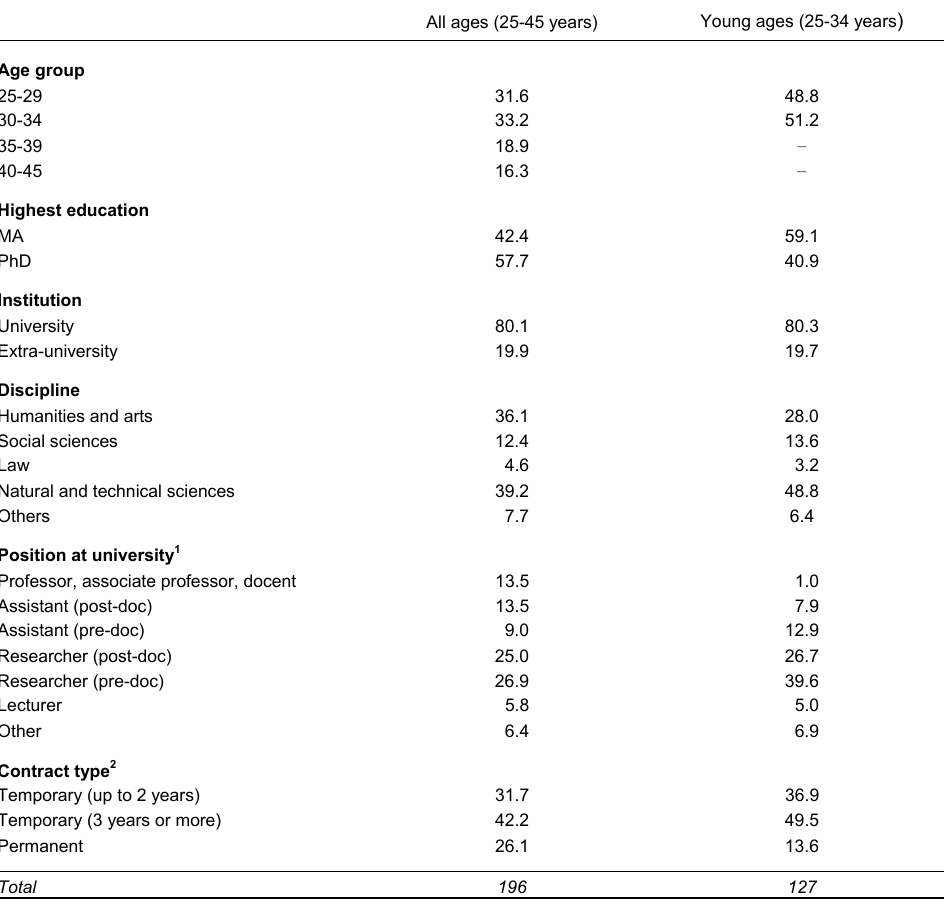
Table 2 : Sample characteristics of female researchers sample (in